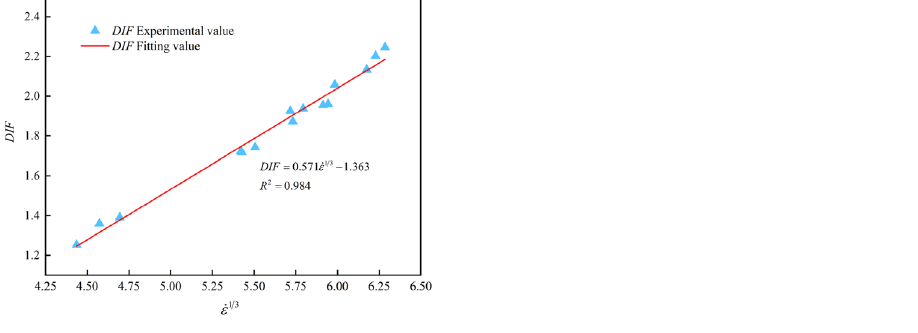
Figure 5. Hardening coefficient DIF changes with ˙ ε